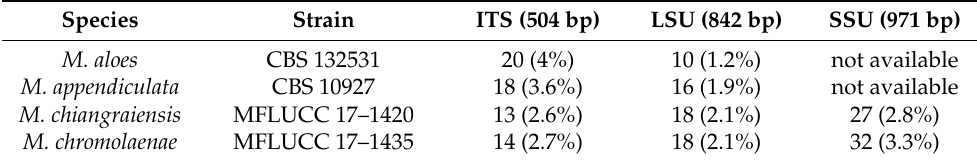
Table 2. The number of polymorphic nucleotide differences between M. guiyangensis HKAS 124556 and M. aloes , M. appendiculata , M. chiangraiensis , and M. chromolaenae (without